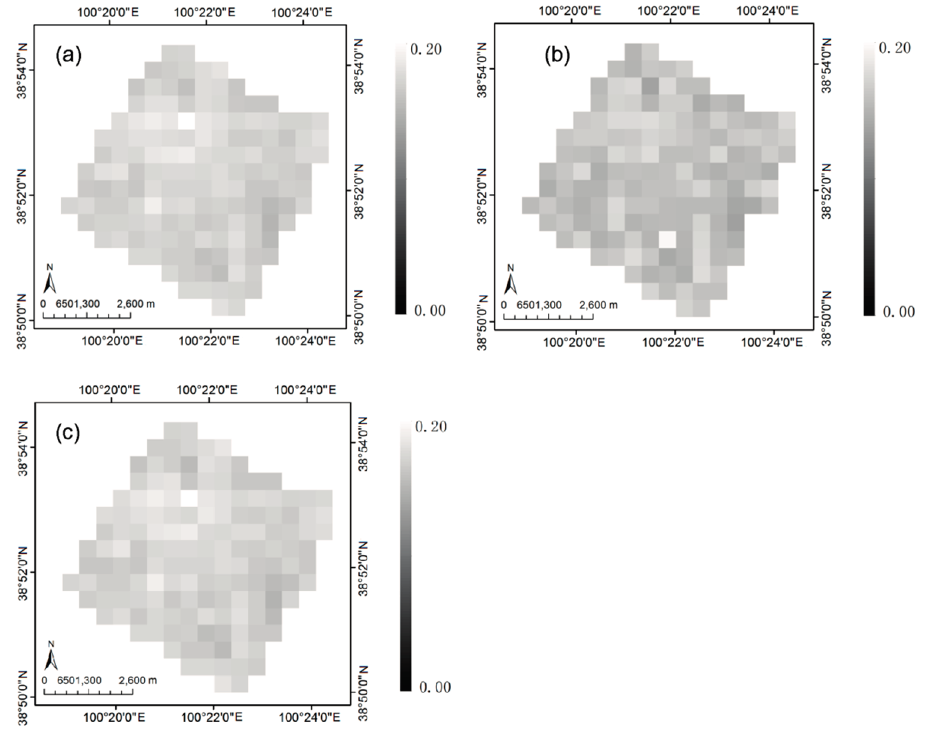
Figure 16. The MODIS albedo. ( a ) is derived from the MODIS BRDF in LLBU denoted by MODIS LLBU ; ( b ) is aggregated from the CASI albedo denoted by CASI agg_ori ; ( c ) is aggregated from the corrected CASI albedo by